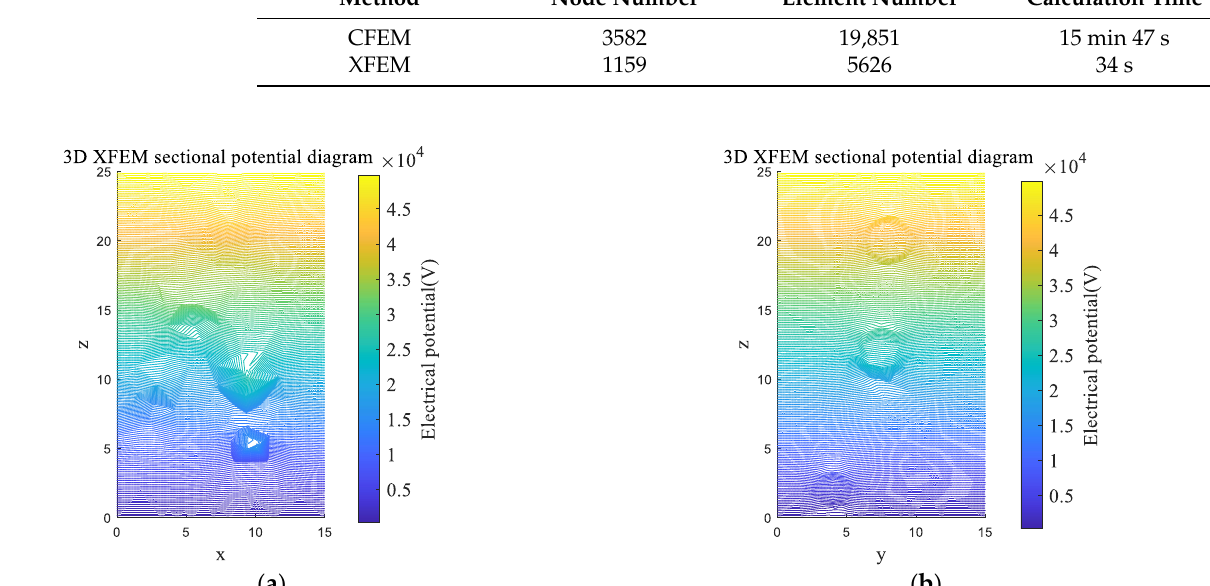
Table 7. Contrast of number of nodes and elements.